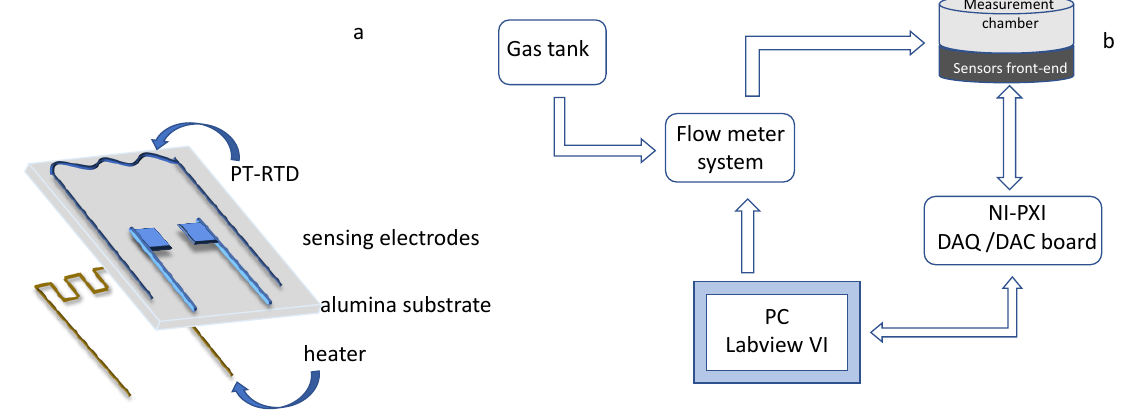
Figure 1. Schematic representation of the sensors’ structure ( a ) and of the gas measurement and characterization system ( b ).